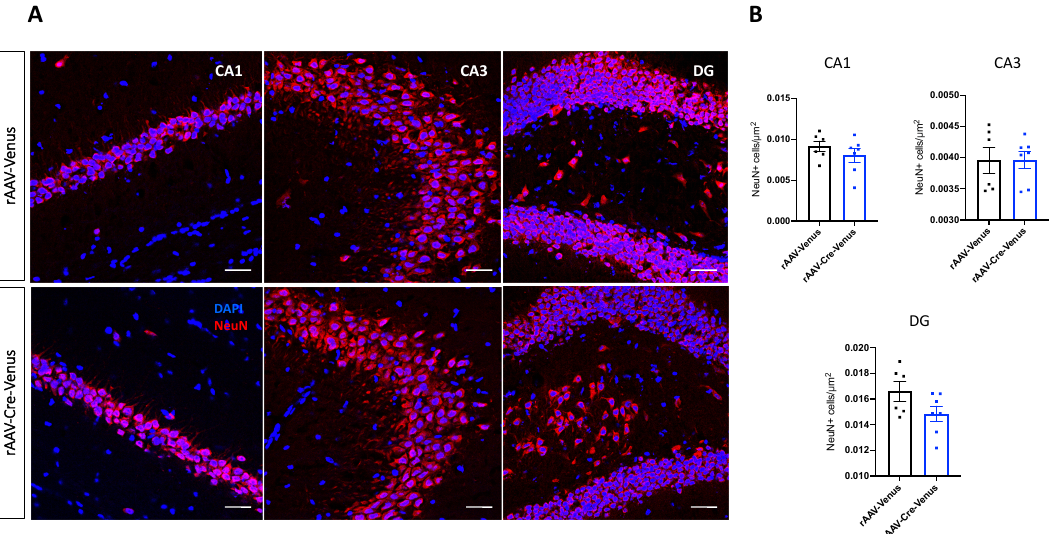
Figure 4. Representative confocal microscopy photomicrographs showing Ki-67 (red) and DAPI (blue) staining ( A ) in the subgranular zone (SGZ) of the dentate gyrus (DG) of the hippocampus and ( B ) in the subventricular zone (SVZ) of the lateral ventricle (LV) and ( C ) their quantification. Scale bar 50 µ m. Individual data points and mean value ± SEM are shown. Student’s unpaired t -test. ** p < 0.01.